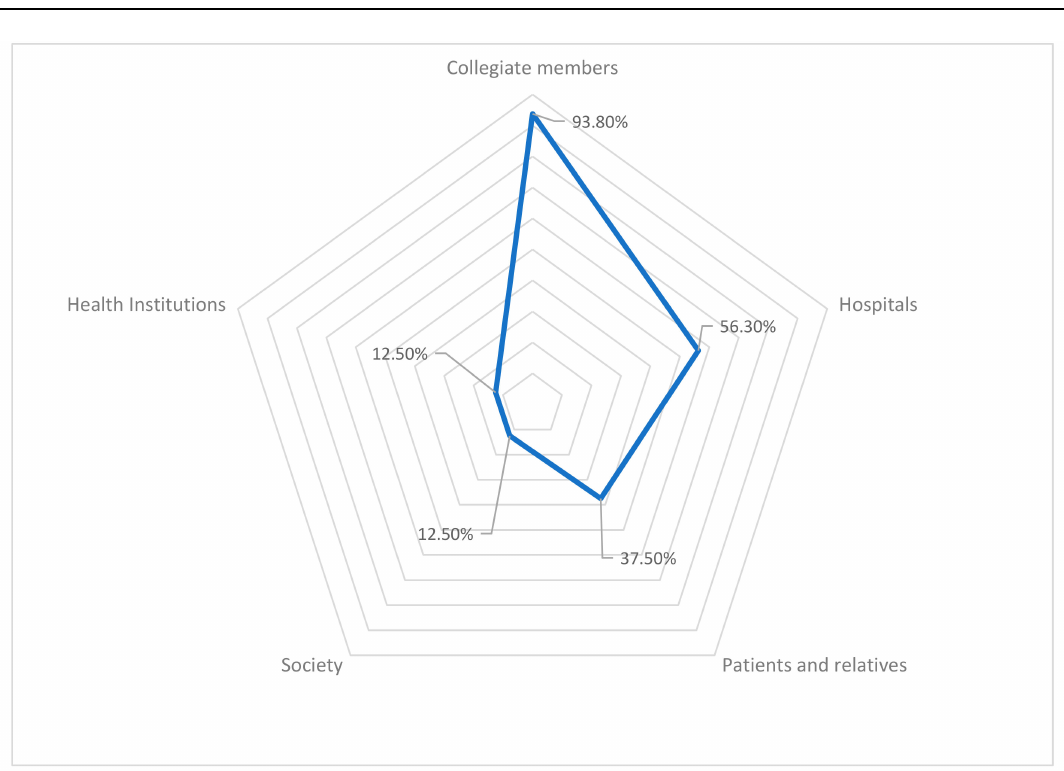
Figure 3. O ffi cial medical colleges (OMC) relations with their primary stakeholders. The percentage indicates the relationship with each stakeholder. Source: In-house